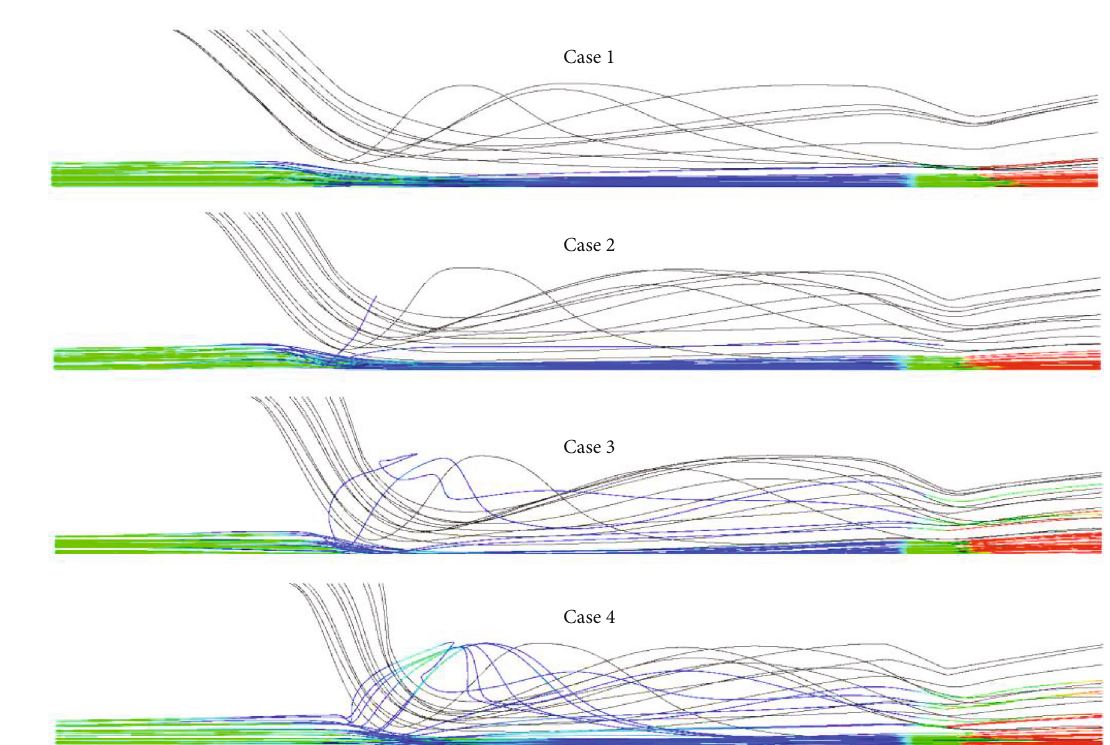
Figure 8: Streamlines of primary gas and